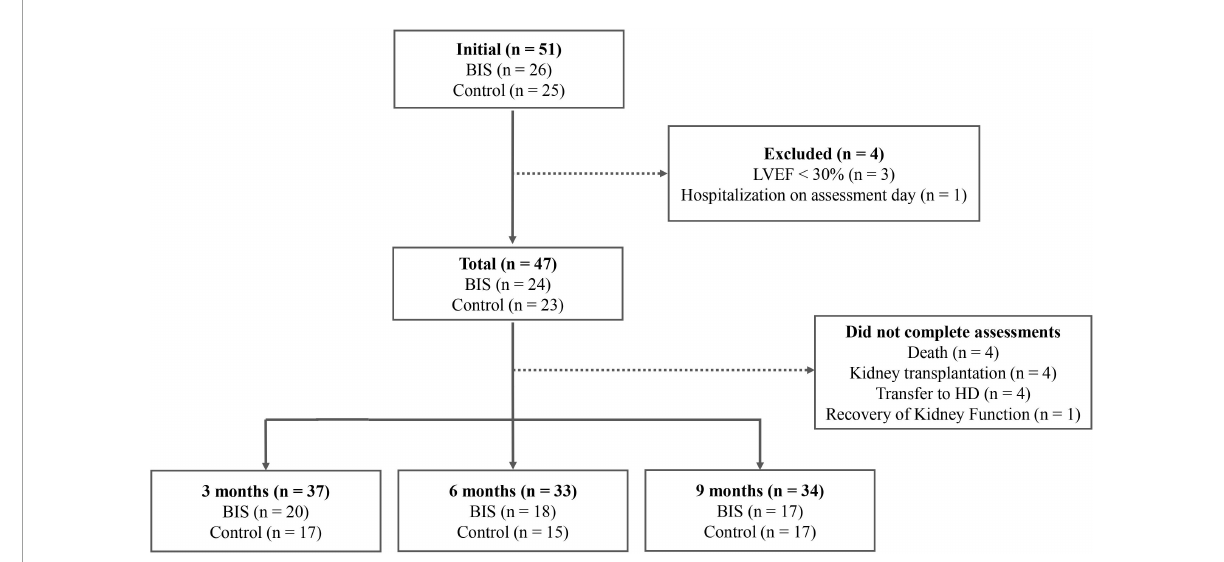
FIGURE1 Flowchart of the participants in the different evaluation moments. LVEF, Left ventricular ejection fraction.